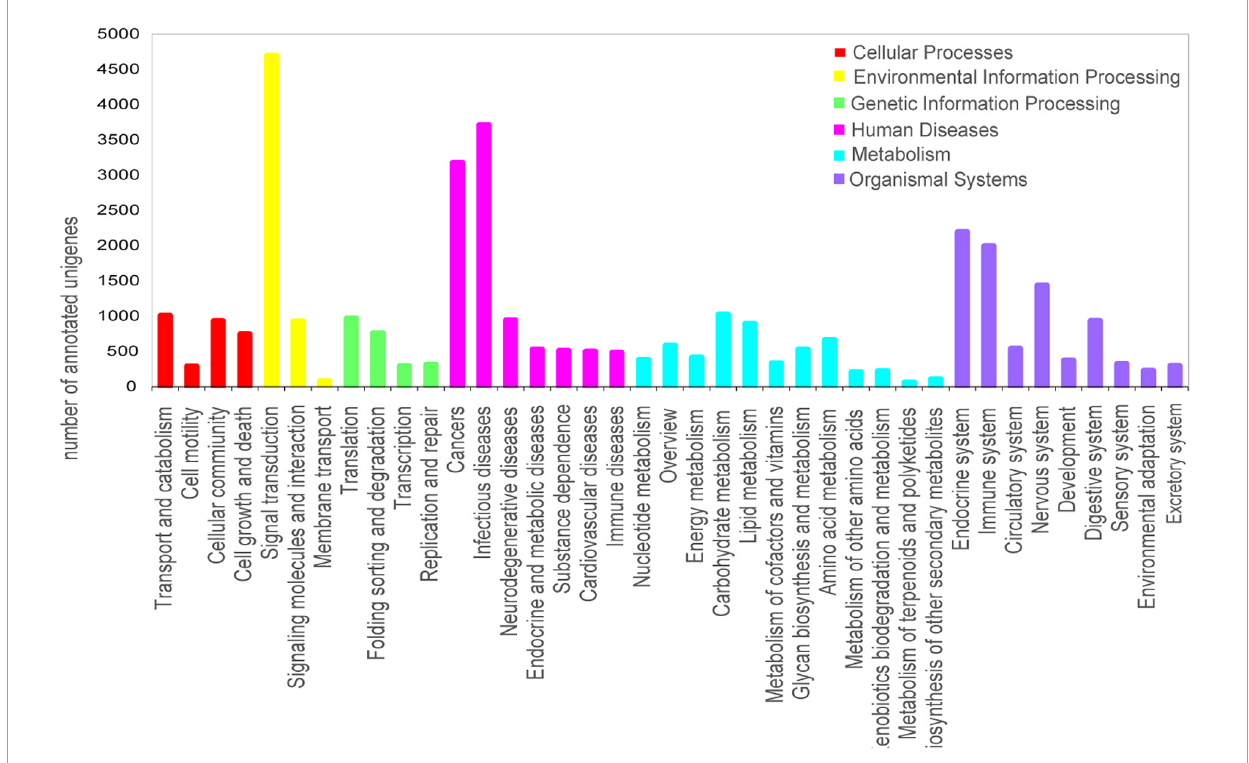
FIGURE3 Histogram of Kyoto Encyclopedia of Genes and Genomes (KEGG) pathway annotation of the unigenes in O. grminea . The six main KEGG classifications were displayed in different colors. The x-axis represented the annotated pathway, and the y-axis represented the number of annotated unigenes.